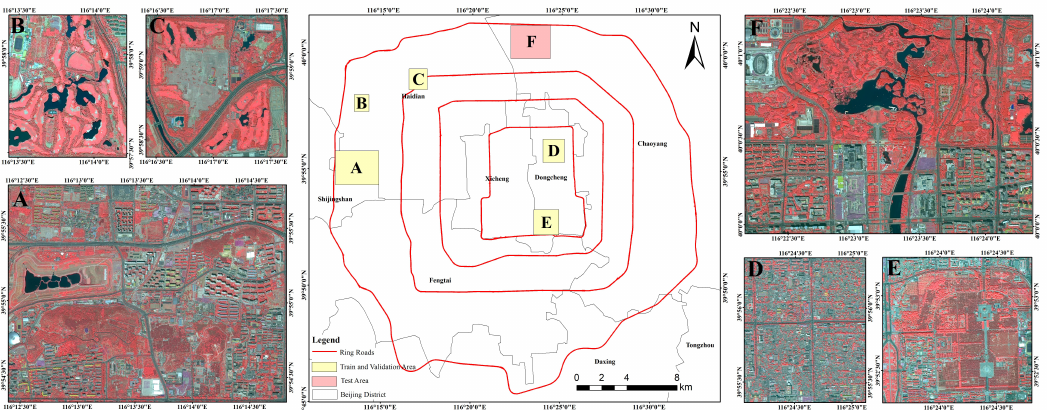
Figure 1. Study Area. Region A is Laoshan urban leisure park. Region B is Xiangshan golf course. Region C is Wanliu golf course. Region D is Zhangzizhong Road residential. Region E is Temple of Heave Park. Region F is Olympic Park. Region A–E are the train and validation data, and Region F